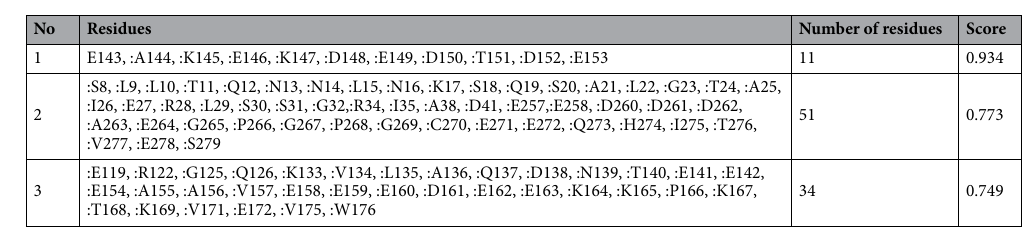
Figure 4. The validation of the final 3D model. ( A ) PROCHECK’s Ramachandran plot illustrates that the residues are placed in the allowed (96%) and favored (4%) regions. ( B ) ProSA Z-score plot shows a -2.84 score in the range of conformation of the native protein. ( C ) ERRAT plot showed the overall quality factor to be 98.06%.